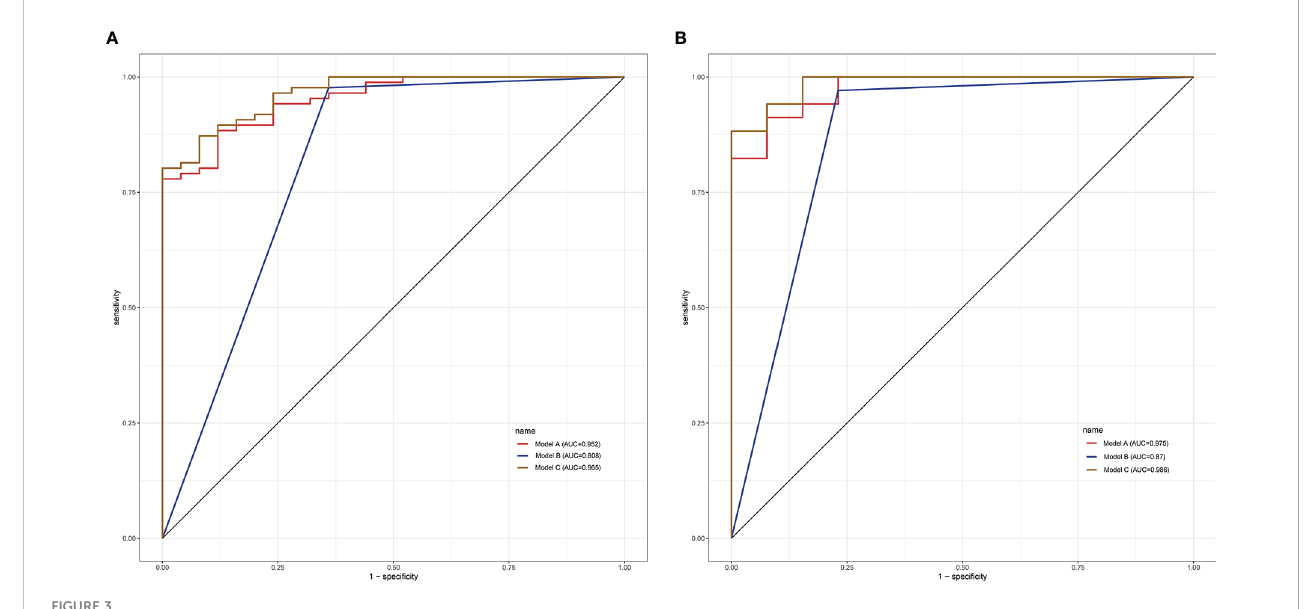
FIGURE 3 ROC curve analysis in the training group (A) and validation group (B) .